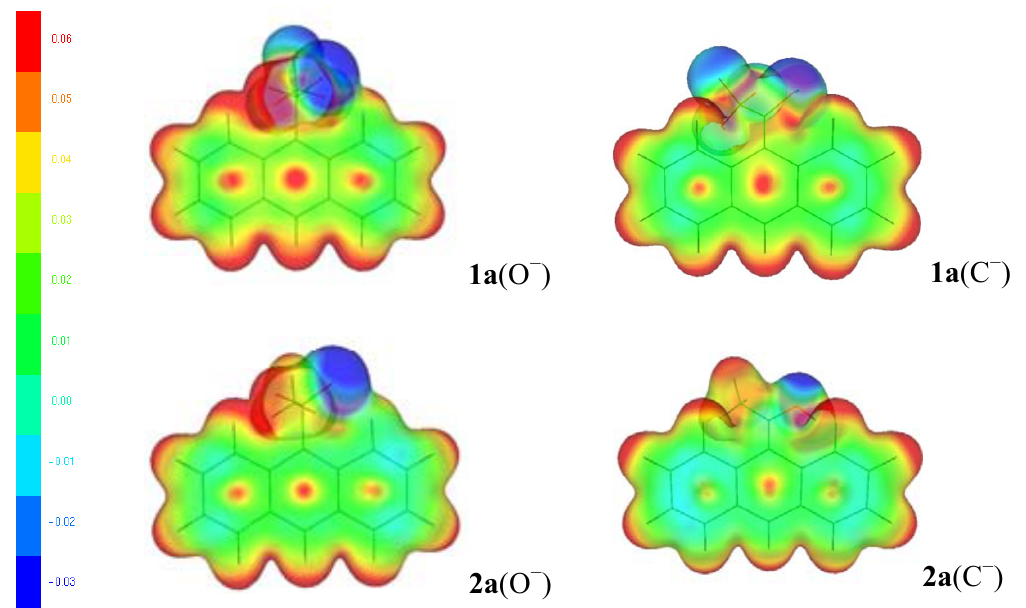
Figure 5. MEP mapped onto an isosurface of the total electron density for the alkoxides (O − ) and carbanions (C − ) of 1a and 2a